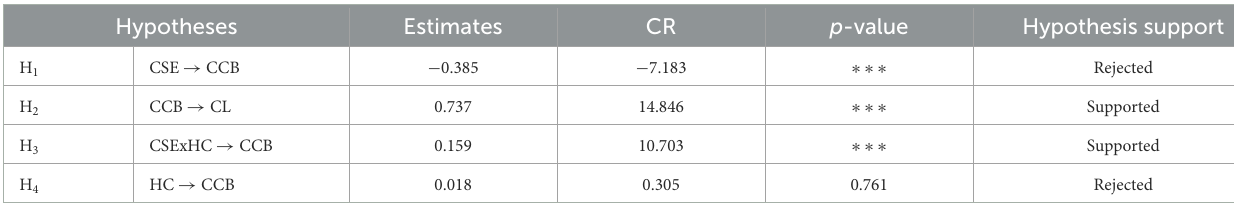
TABLE 3 Results of the hypothesis test ( n =